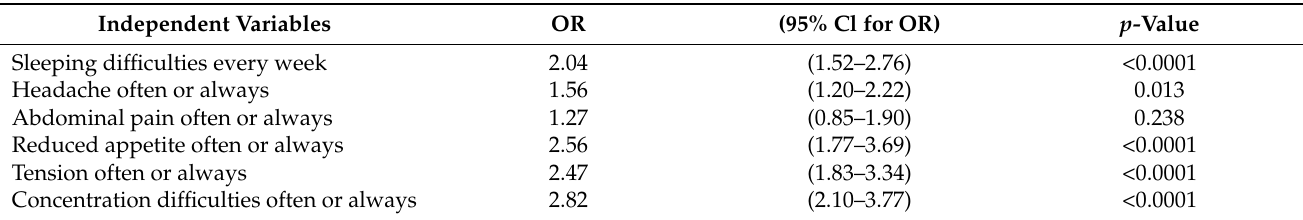
Table 2. Logistic regression analysis of factors related to sadness (often or always) among Swedish adolescents aged 15–17 years ( n = 1489).